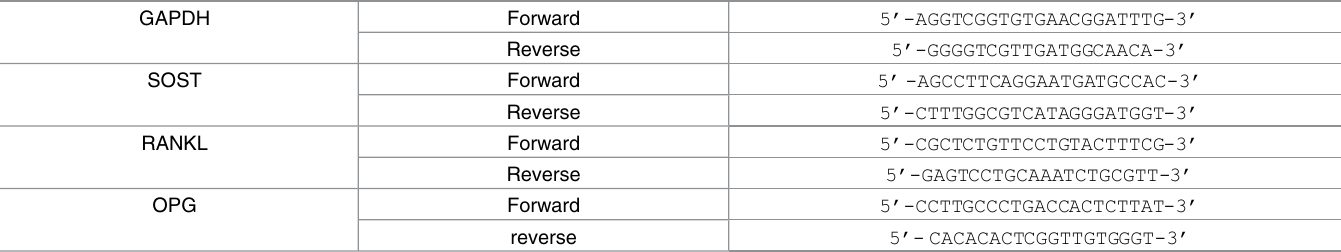
Table 1. Primer sequences of Real-time RT-qPCR.